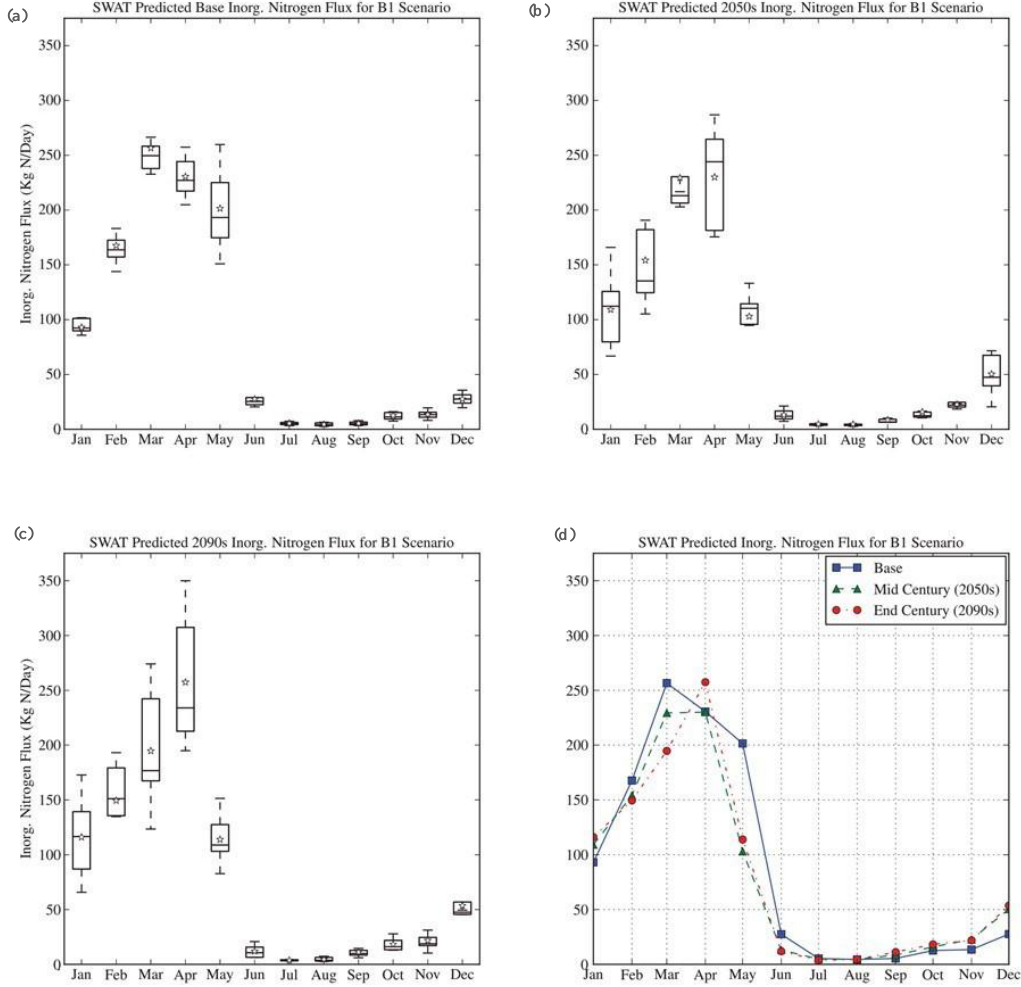
Figure 8. SWAT predicted monthly average inorganic nitrogen loading. ( a ) Base period (1970–2000); ( b ) Mid Century (2048–2065); ( c ) End Century (2085–2099); from eight GCMs predicted B1 emission scenarios at EPA station J0770000; and, ( d ) the average inorganic nitrogen loading over the eight GCMs for the three study periods.